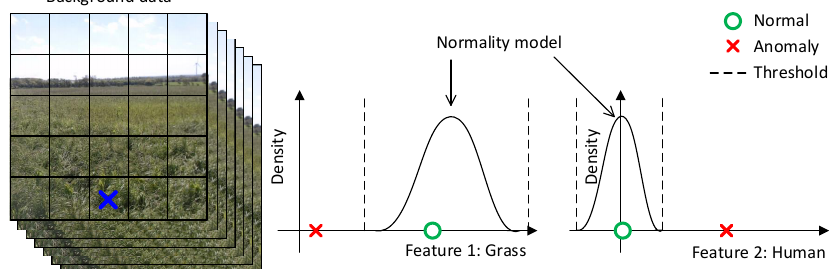
Figure 6. Representation of the background subtraction module for only a single feature map entry and two